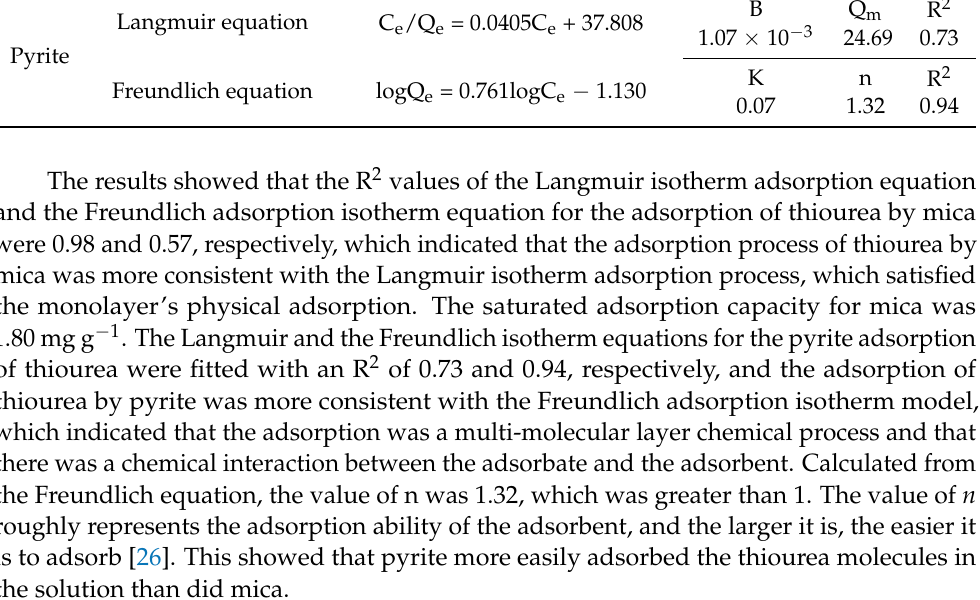
Table 1. Fitting results of the isotherm equations for thiourea’s adsorption on mica and pyrite. Minerals Items Fitting Results Parameters Langmuir equation C e /Q e = 0.5561C e + 0.0001 Mica Freundlich equation logQ e = 0.2456logC e − 0.244 Langmuir Pyrite